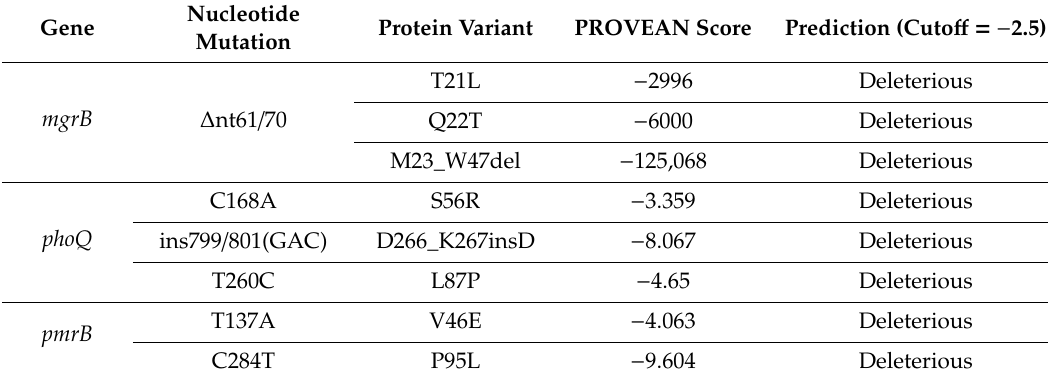
Table 2. PROVEAN analysis of new mutations in colistin-resistance related genes. Nucleotide Protein Variant PROVEAN Score Prediction (Cuto ff = − 2.5) Gene Mutation T21L − 2996 Deleterious mgrB ∆ nt61 / 70 Q22T − 6000 Deleterious M23_W47del − 125,068 Deleterious C168A − 3.359 Deleterious phoQ